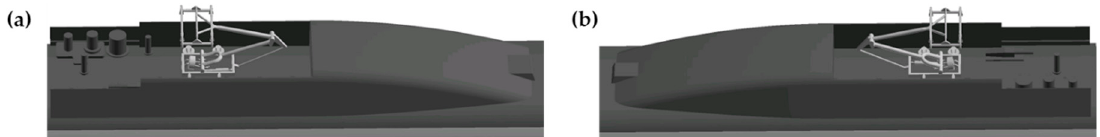
Figure 11. Simplified roof fairing and pantograph models: ( a ) first pantograph and roof pairing on the M1 car; ( b ) second pantograph and roof fairing on the M3 car.